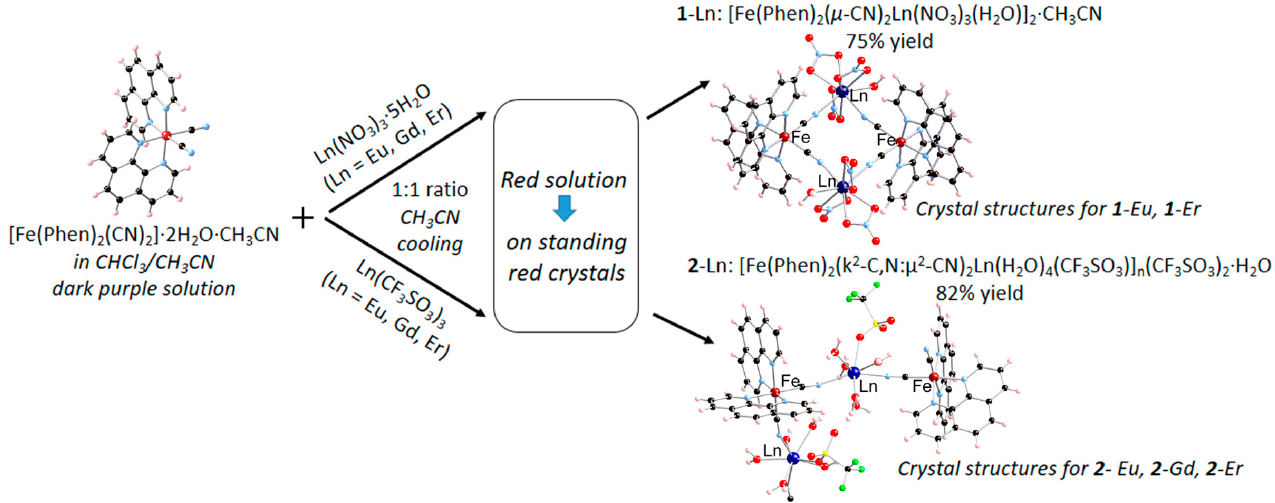
Table 1. Summary of X-ray crystallographic data for 1 -Ln.